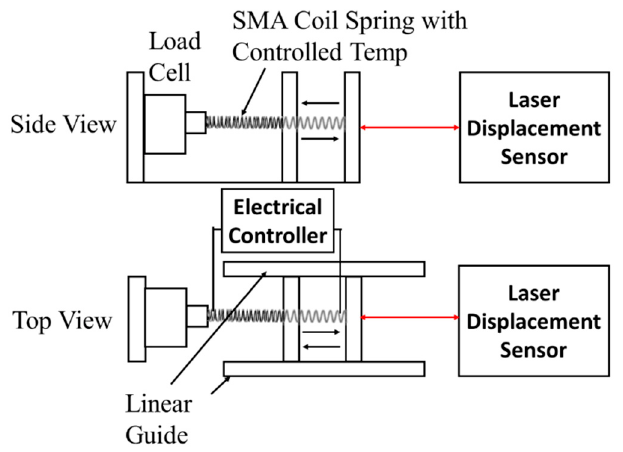
Figure 3. Experimental Setup for force-displacement measurement of SMA coil Figure 3 . Experimental Setup for force-displacement measurement of SMA coil spring .